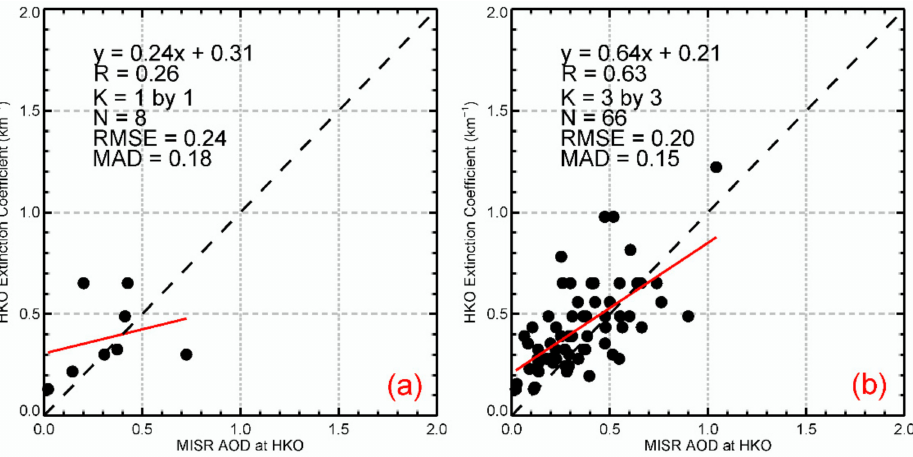
Figure 7. Like Figure 6, but at HKO, ( a ) 1 by 1 and ( b ) 3 by 3.